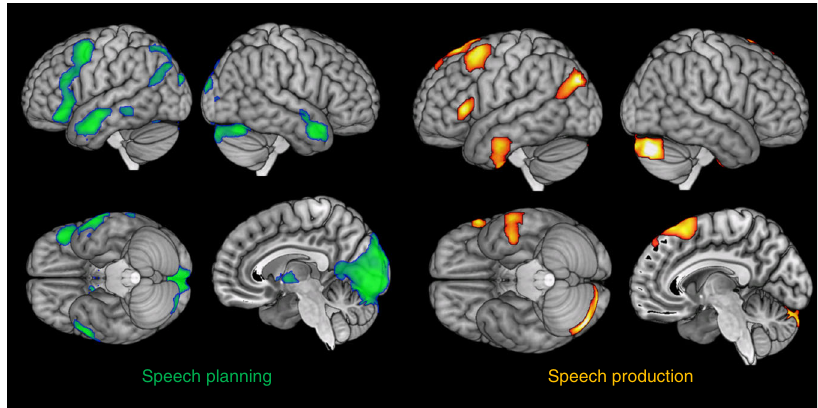
Fig. 2 Activation for speech planning and production. Planning and production of extended speech were contrasted with the automatic speech baseline